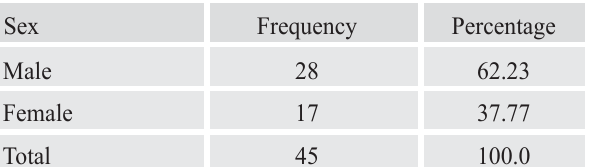
Table I: Sex distribution of Hodgkin lymphoma patients (n=45)